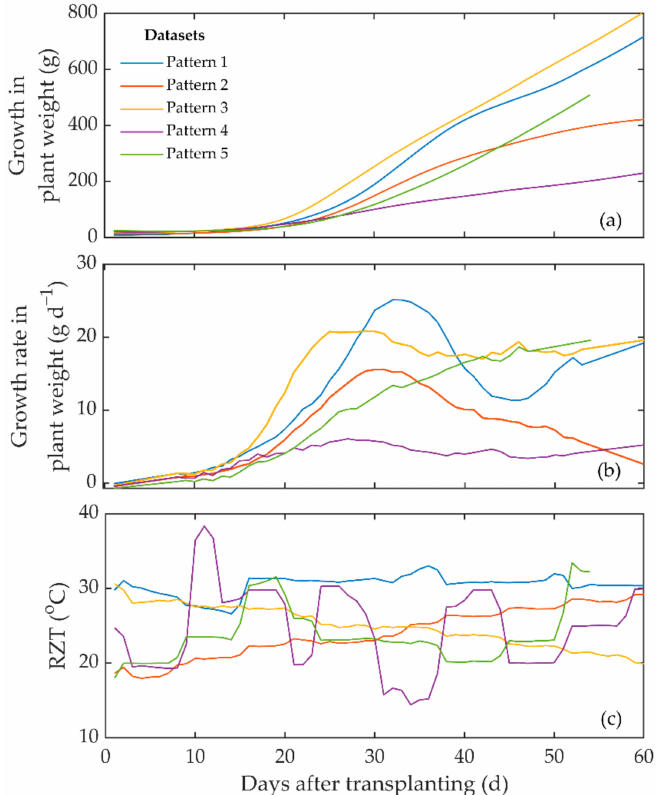
Figure 5. Typical daily change in plant weight ( a ), the growth rate in plant weight ( b ), and the RZT ( c ) in hydroponic pepper